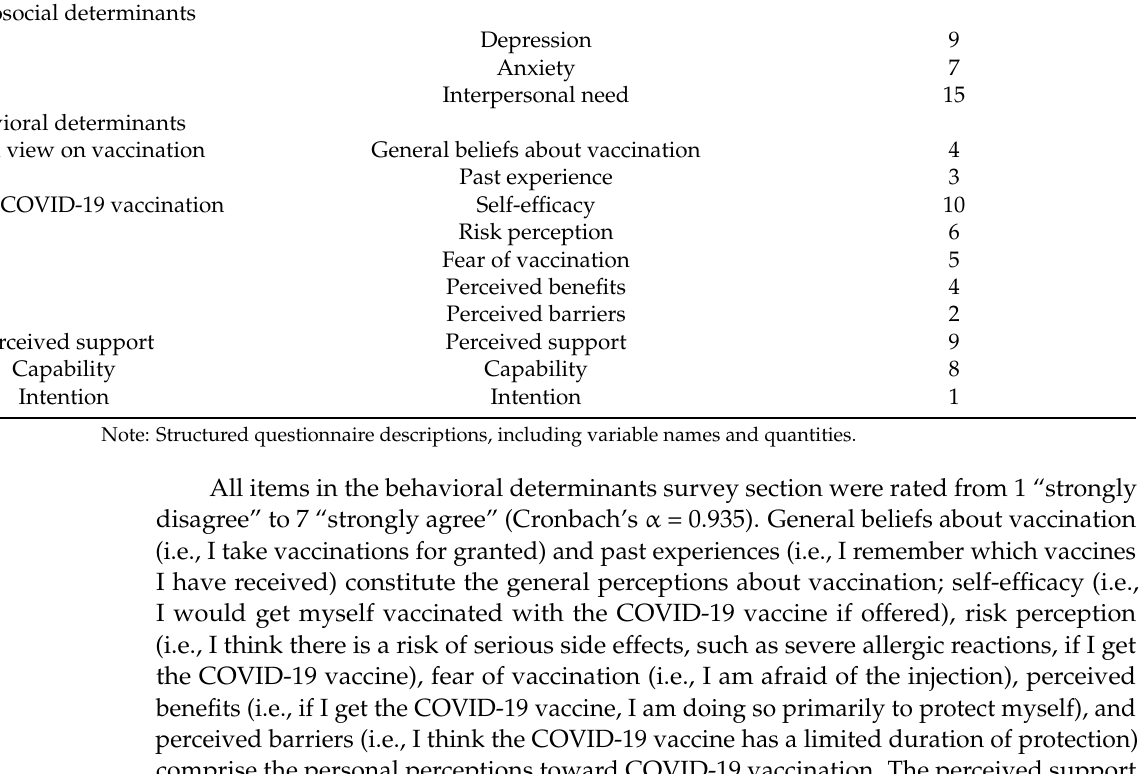
Table 1. Personal, psychosocial and behavioral determinants of COVID-19 vaccination intention. Determinants Determinants Measured Number of Items Personal determinants Demographic